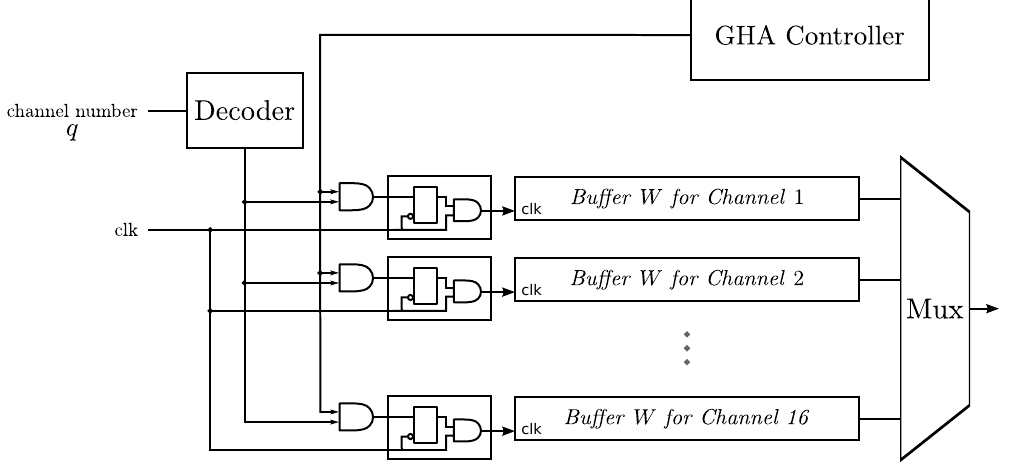
Figure 10. The clock gating circuit for lowering the dynamic power consumption of the multi-channel GHA circuit for feature